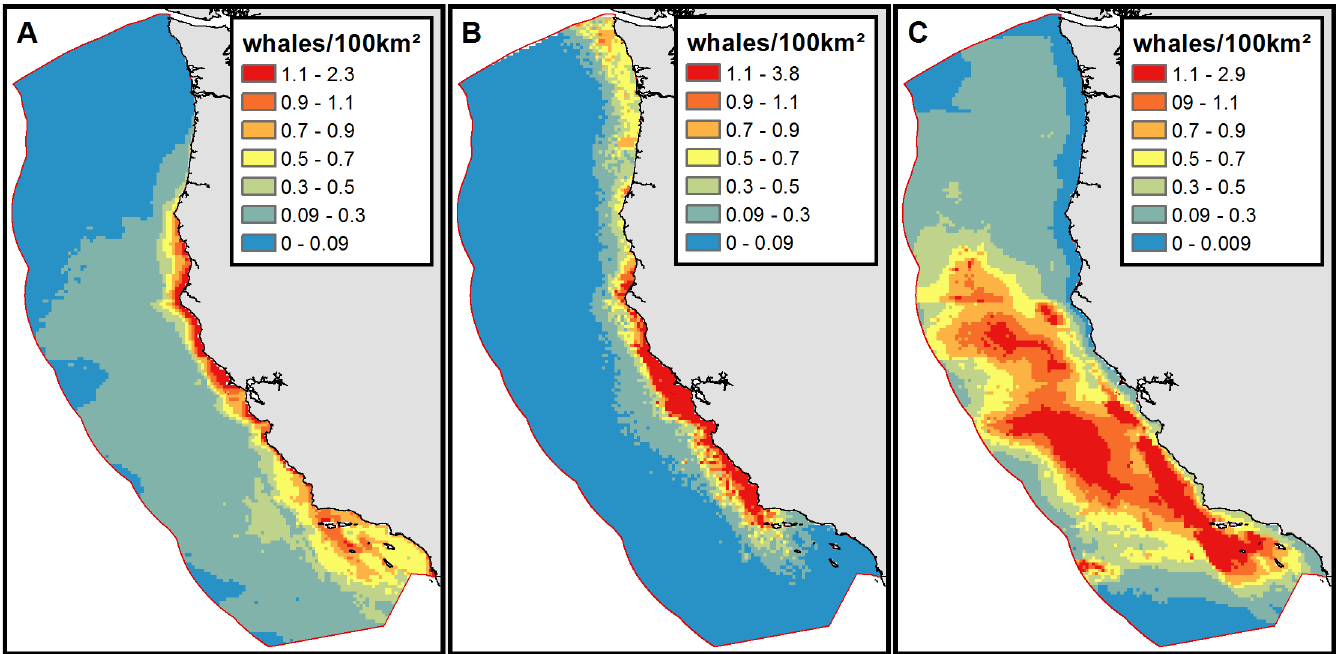
Fig 1. Species Distribution Model density blue whales (A), humpback whales (B), and fin whales (C). Density predictionsderivedfrom Becker et al. 2016. Note that to facilitate comparisonacross species, the scale breaks are the same with the exceptionof the top class maximum.